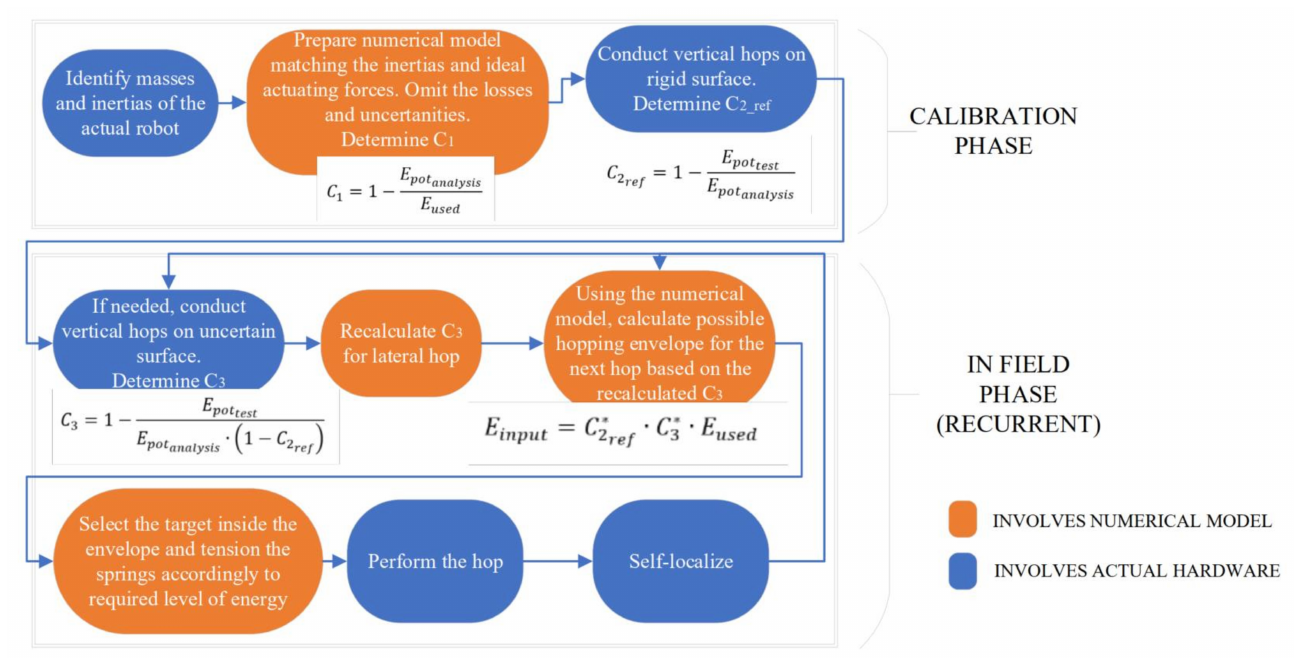
Figure 24. Structured control algorithm for trajectory planning, including energy dissipation